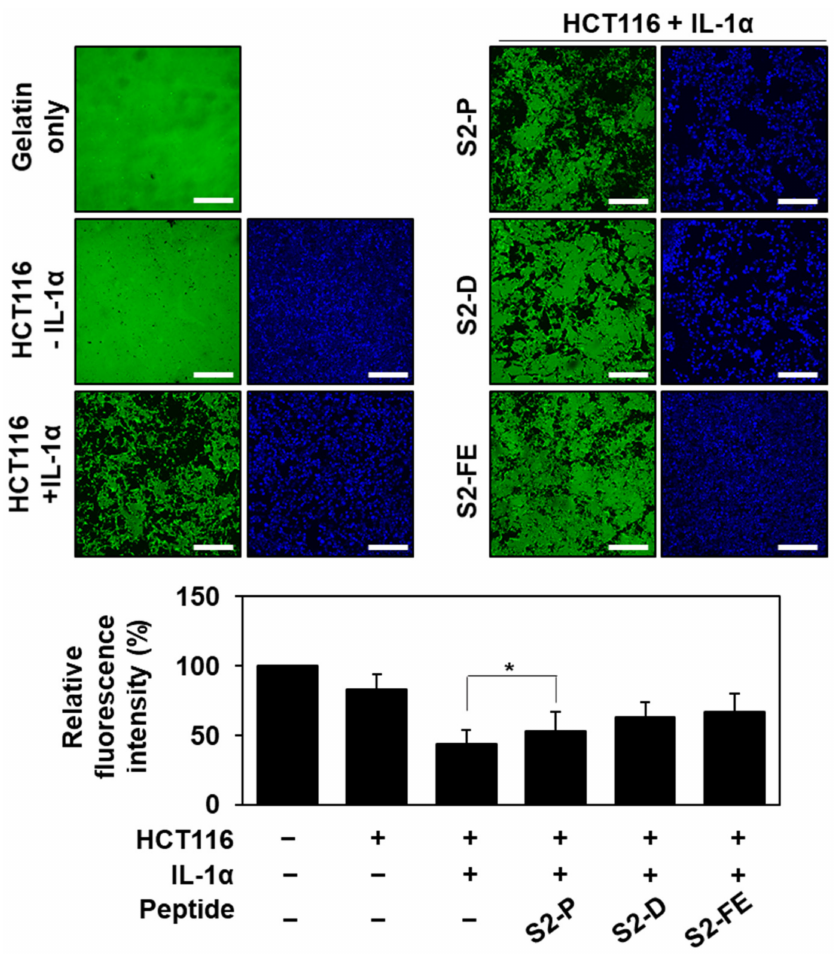
Figure 6. The synthetic peptides inhibited the activity of MMP-7 in colon cancer cells. HCT116 cells were treated with or without 1 ng/mL of interleukin 1 alpha (IL-1 α ) and plated on cover glasses in a 24-well plate precoated with fluorescent Oregon-Green-488-conjugated gelatin substrate in the presence or absence of the indicated peptides (50 nM). After 24 h, additional peptides were treated (50 nM). After total 48 h incubation, microscopic fields were photographed. Representative fluorescent images are shown. Scale bar: 200 µ m. Quantitative analysis of fluorescence intensity of gelatin in cover glasses were performed using ImageJ program. Data are shown as mean ± S.D. ( n = 3); *, p < 0.05 versus